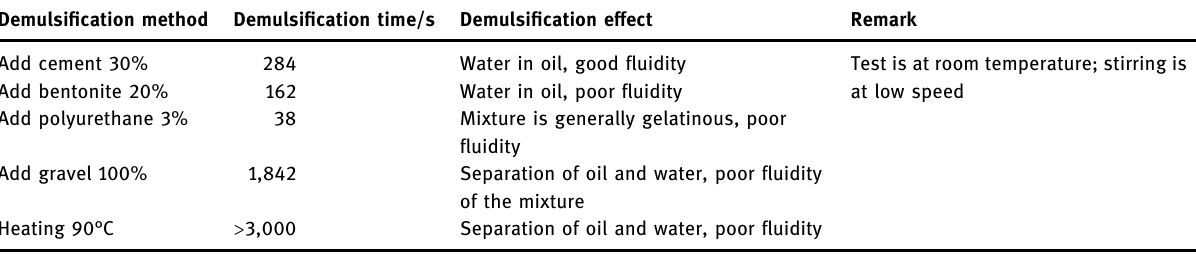
Table 1: Results of the demulsi fi cation test of emulsi fi ed